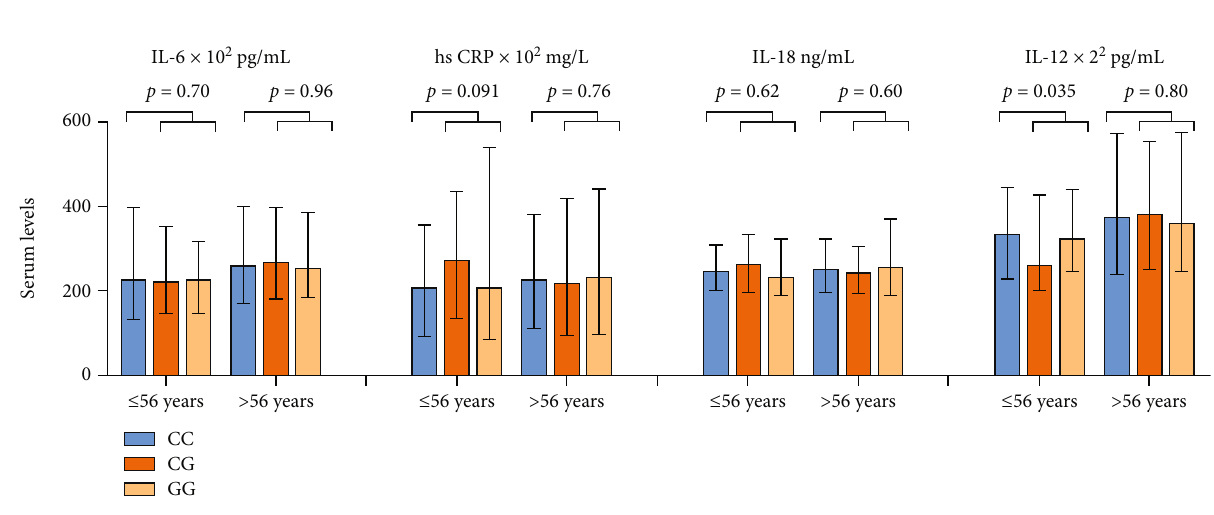
Figure 3: Levels of circulating IL-6, hs CRP, IL-18, and IL-12 according to NLRP3 genotypes Blue, orange, and pale orange columns represent homozygous wild type (CC), heterozygous (CG), and homozygous of the gene variant (GG), respectively. Results are dichotomized according to age at the 25 percentile level (56 years). p values represent di ff erence in circulating levels of each marker between the CC genotype and CG/GG combined (Mann – Whitney